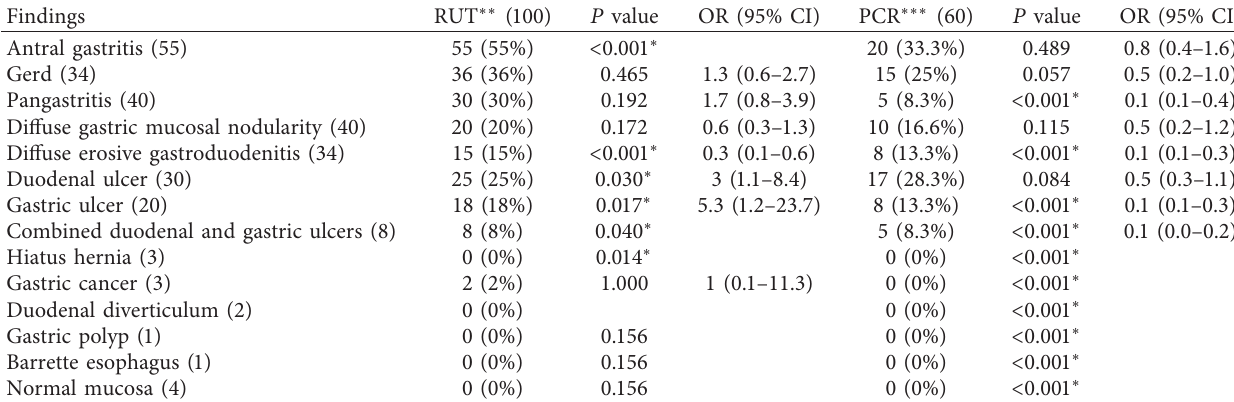
Table 2: Endoscopic findings in relation to RUT and PCR.